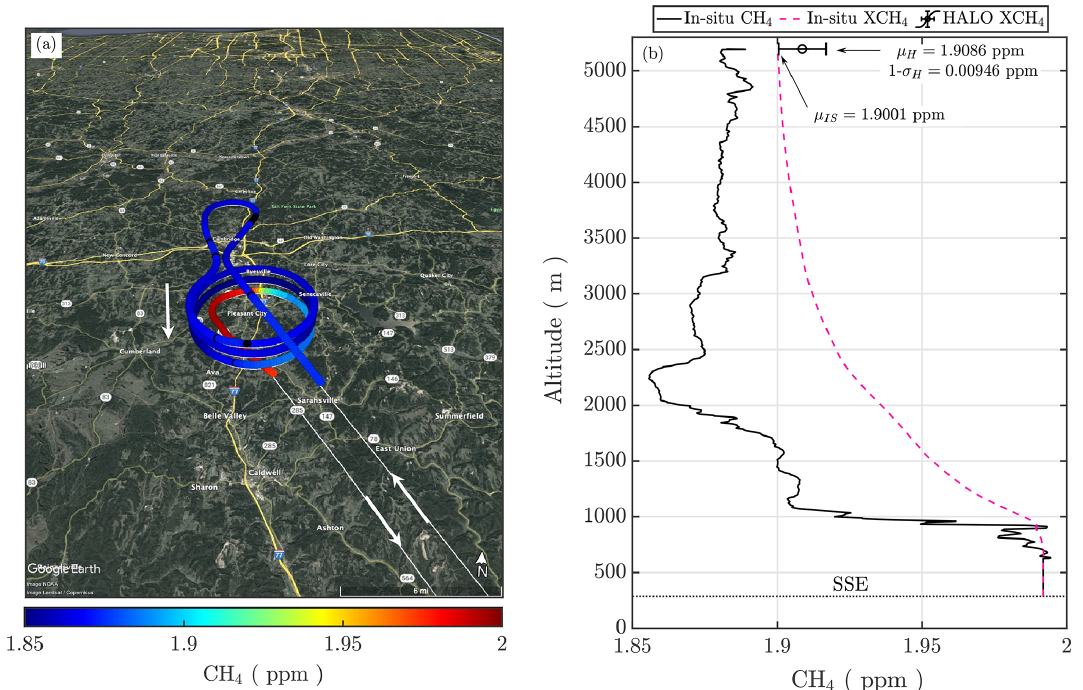
Figure 10. (a) C-130 flight track and in situ CH 4 profile from the 20 July flight (©Google Maps). (b) In situ CH 4 mole fraction profile as measured during a descent spiral from approximately 5km to the ground height (SSE), in black. Overlaid is the in situ-derived XCH 4 in magenta using HALO’s weighting function. The in situ-derived XCH 4 at flight altitude was µ IS = 19001ppm, shown as the top point of the magenta curve, and the black error bars show HALO’s overpass mean value with µ H = 19086ppm and 1 σ H = 946ppb.